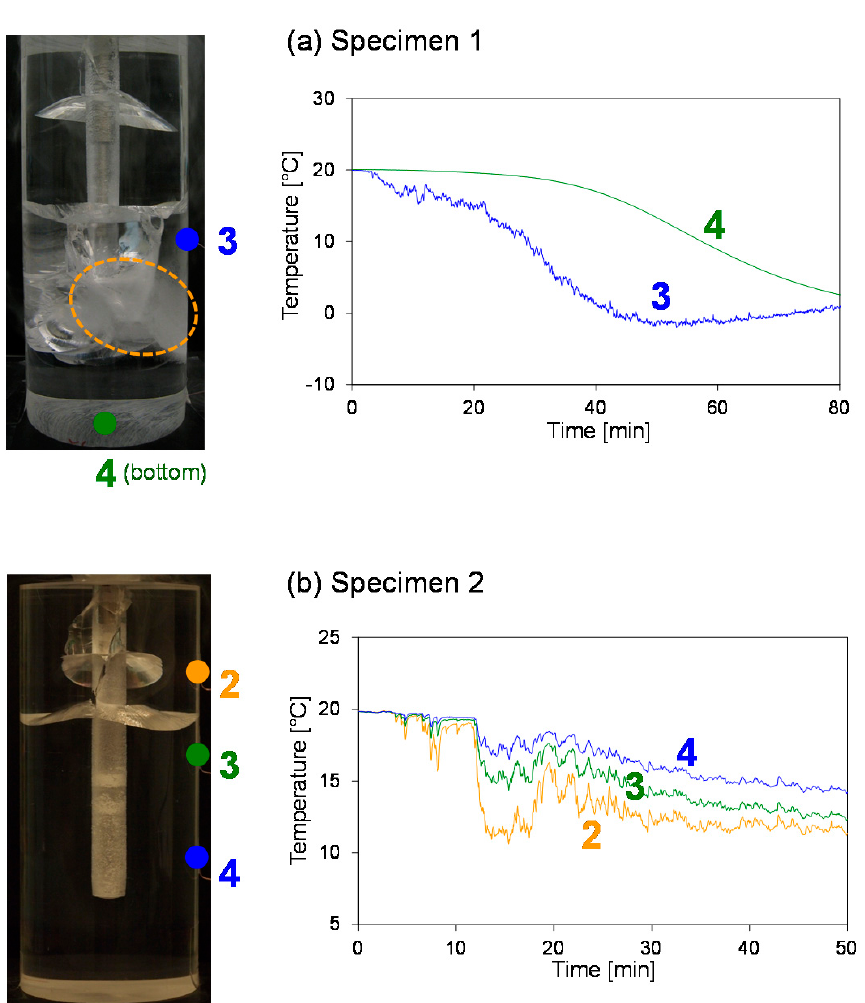
Figure 10. Effect of crack propagation on the surface temperature. Local frost due to surface temperature below 0 °C appeared in the circled area of Specimen 1 where a fracture reached the surface.